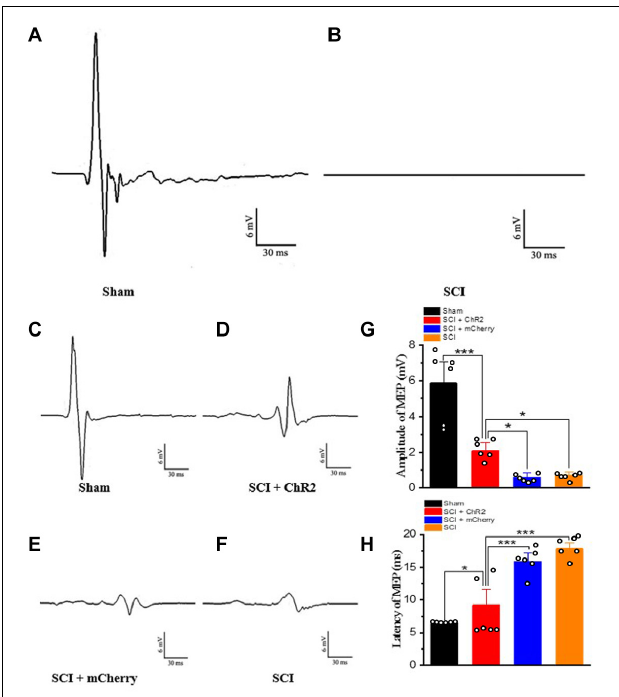
FIGURE 4 | Accurate stimulation of M1 glutamatergic neurons in rats after SCI. (A) The results of motor evoked potentials on the first day after operation in the sham group. (B) The results of motor evoked potentials of SCI rats on the first day after the operation. (C–F) The test results of motor evoked potentials of the corresponding groups at the 6th week, respectively. (G) The histogram display of the amplitude of motor evoked potentials of each group. (H) The histogram display of the incubation period of the motor evoked potentials of each group. [*indicates P < 0.05, *** indicates P < 0.001, n = 6 rat/group, using one-way ANOVA. Data are shown as means (bar graphs) and standard error of the mean (error bars), with individual data points indicated as circles].